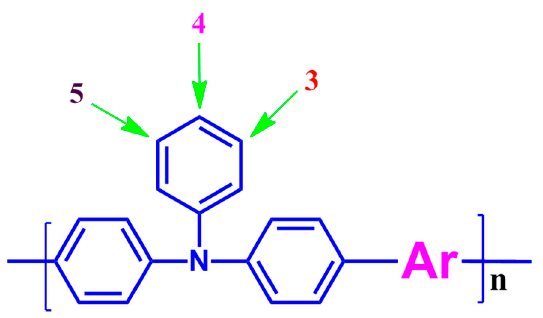
Figure 1. Chemical structure of triphenylamine-based conjugated polymer.